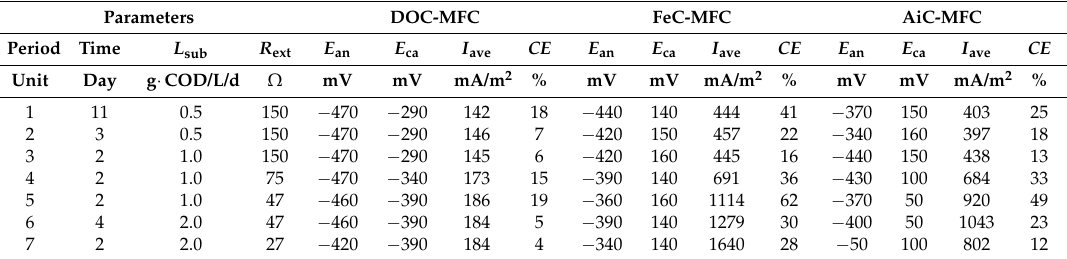
Table 2. Operational parameters including substrate loading rate ( L sub ), external resistance ( R ext ), anode electrode potential ( E an ), cathode electrode potential ( E ca ) and coulombic efficiency ( CE ) for the three cathode types vs. period number. The potential is reported vs. Ag/AgCl reference electrodes. Acetate was used in Period 1 and bioethanol effluent in Periods